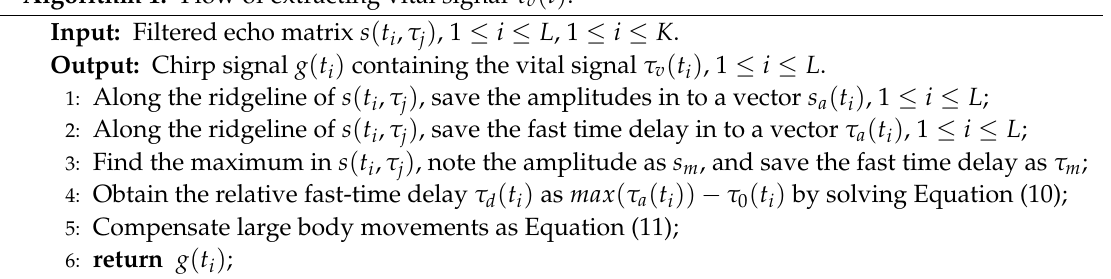
Algorithm 1: Flow of extracting vital signal τ v ( t )